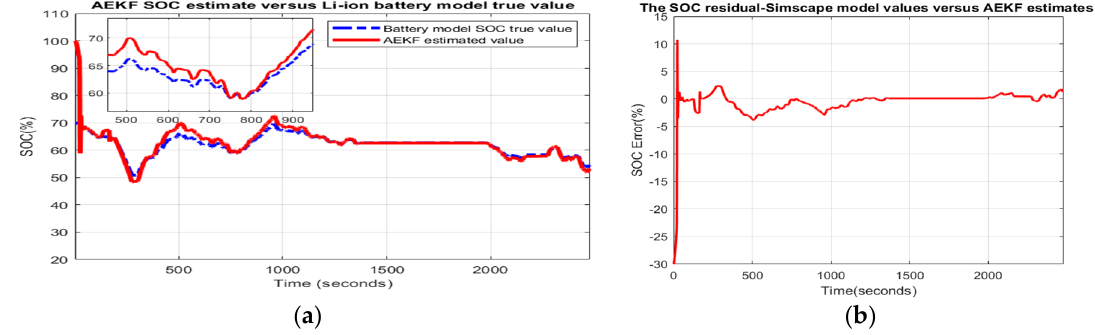
Figure 4. Robustness to simultaneous changes, SOCini = 1, Qnom = 4.2 Ah (ageing effects); ( a ) AEKF